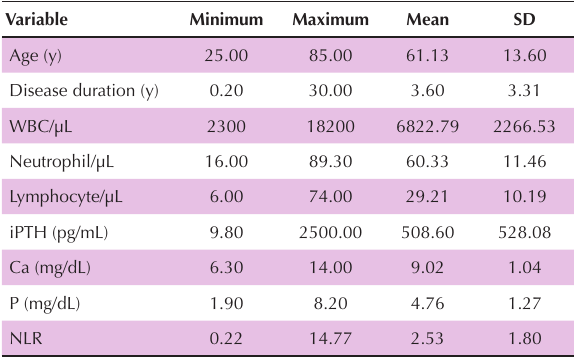
Table 1. Mean and standard deviation of the basic information